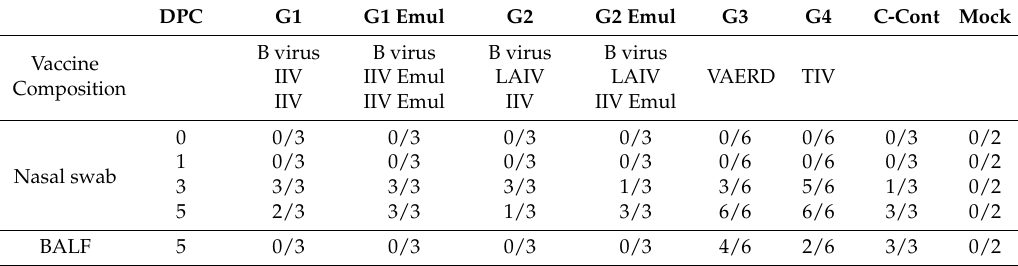
Table 3. Number of virus positive animals per group.